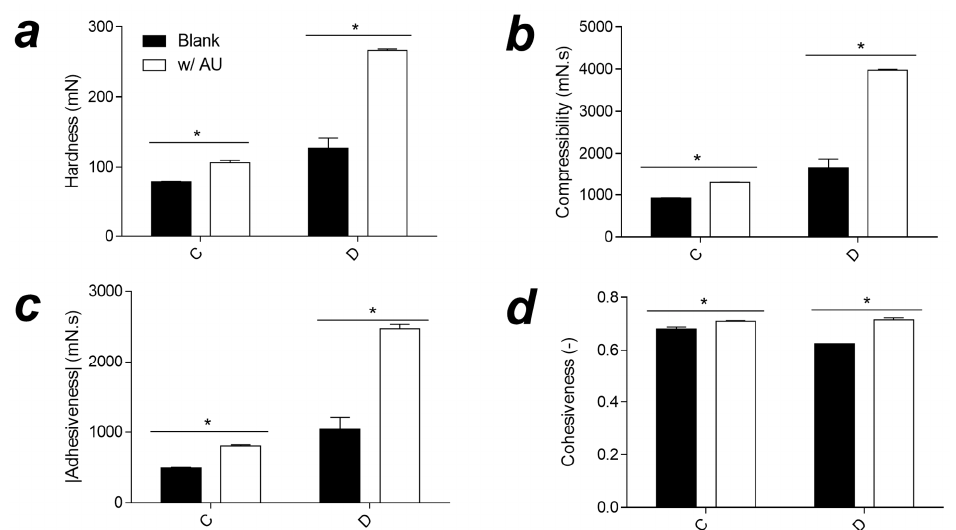
Figure 3. Hardness ( a ), adhesiveness ( b ), compressibility ( c ), and cohesiveness ( d ) obtained from C and D loaded and unloaded with ursolic acid samples. * p < 0.05 between same group. A = formulation with OA%/S%/W% ratio of 40/50/10; B = formulation with OA%/S%/W% ratio of 30/50/20; C = formulation with OA%/S%/W% ratio of 20/50/30; D = formulation with OA%/S%/W% ratio of 10/50/40.